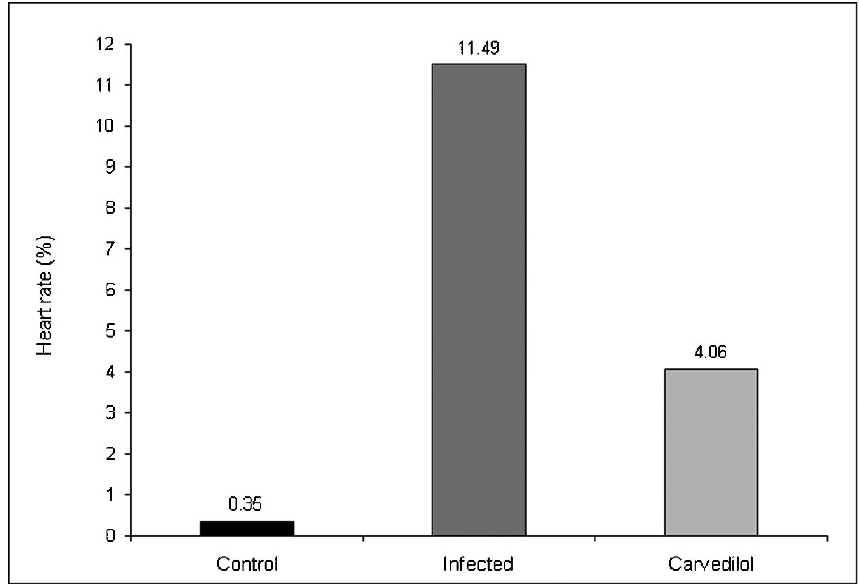
Figure 1 - The percent heart rate variation from baseline to the 11